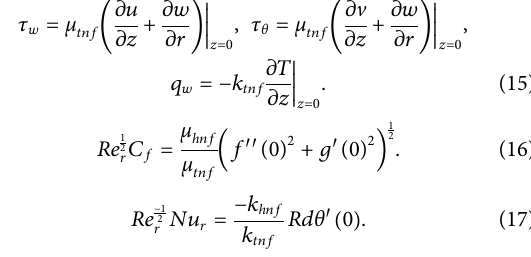
is the local Reynolds number. Table 1 illustrates Here, Re r (cid:3) 2 Ω r 2 v f the experimental values of ternary nanoparticles and base fl uid. Table 2 presented the mathematical model for trihybrid nano fl uid.